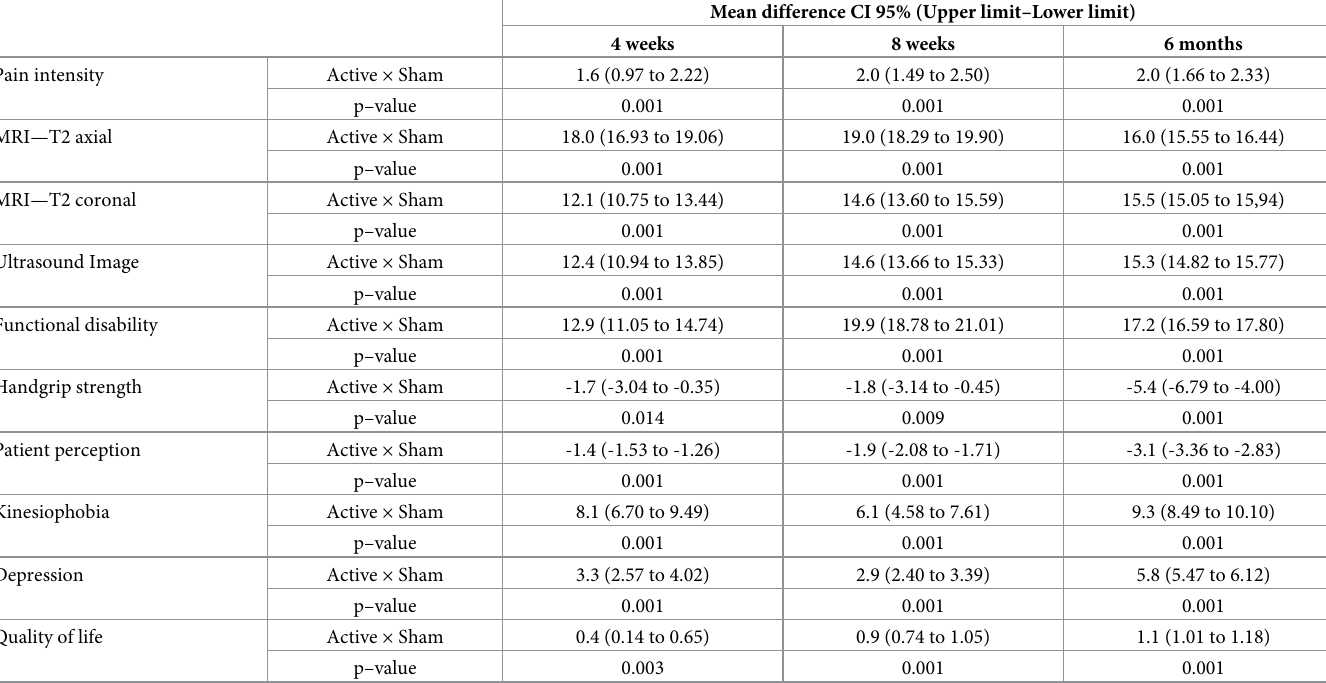
Table 3. Pre and post mean difference and confidence interval (upper limit and lower limit) of primary and secondary outcome scores of active and sham MM